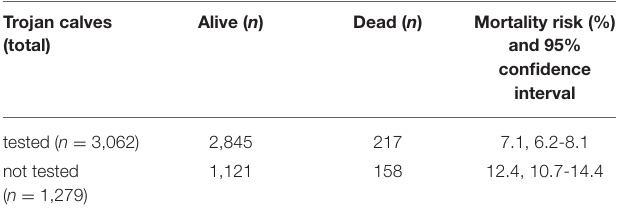
and 95% confidence interval